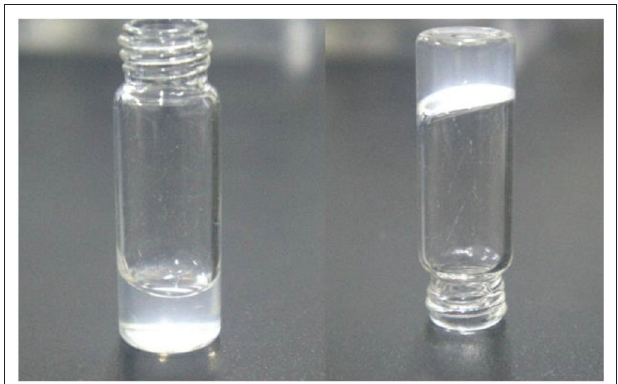
FIGURE 8 | The optical images of the whole PEG based hydrogel (Right, gel H2) and its precursor aqueous solution (left).